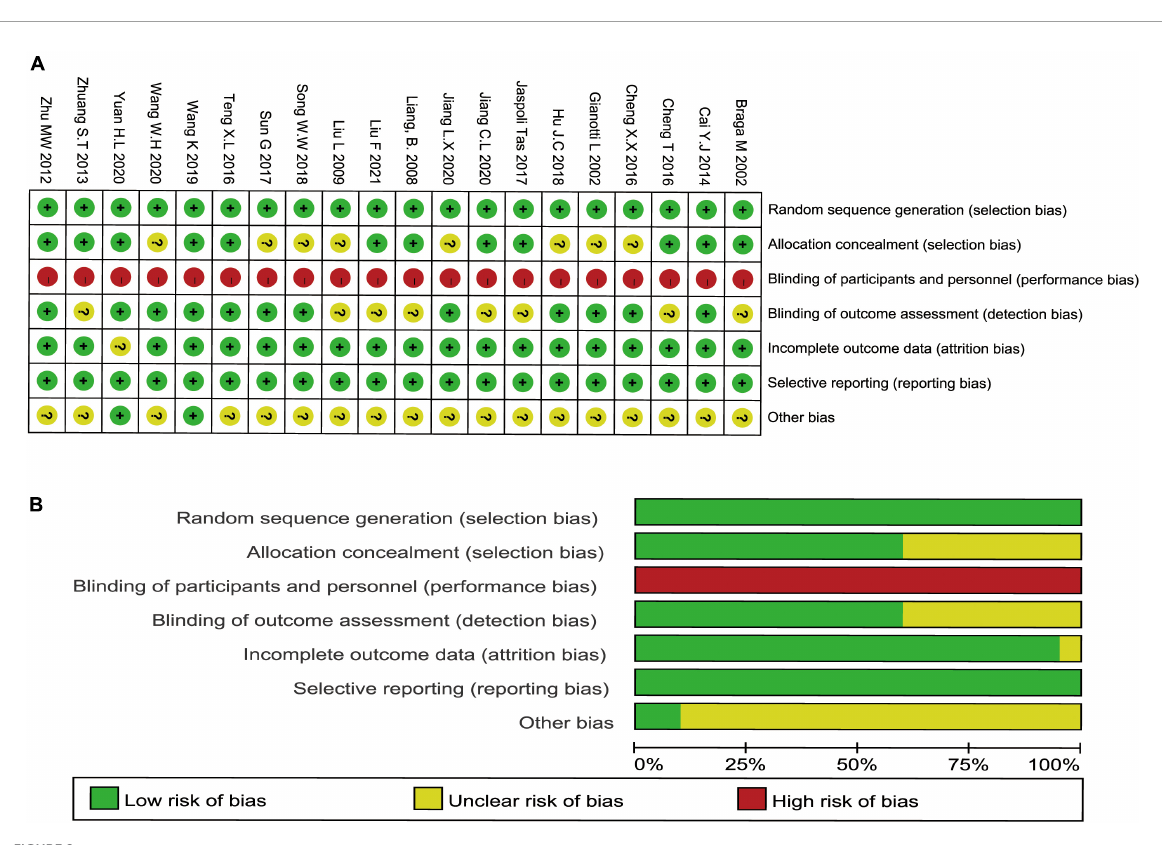
Q -test P = 0.000, Figure 6B ), and PA ( I 2 test = 90.4% and Q